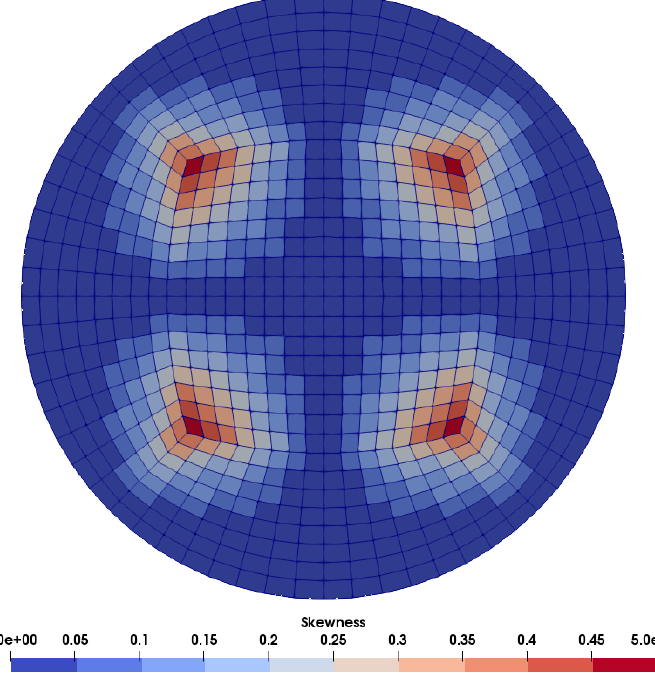
Figure 5. Skewness of the mesh within a given cross section of the